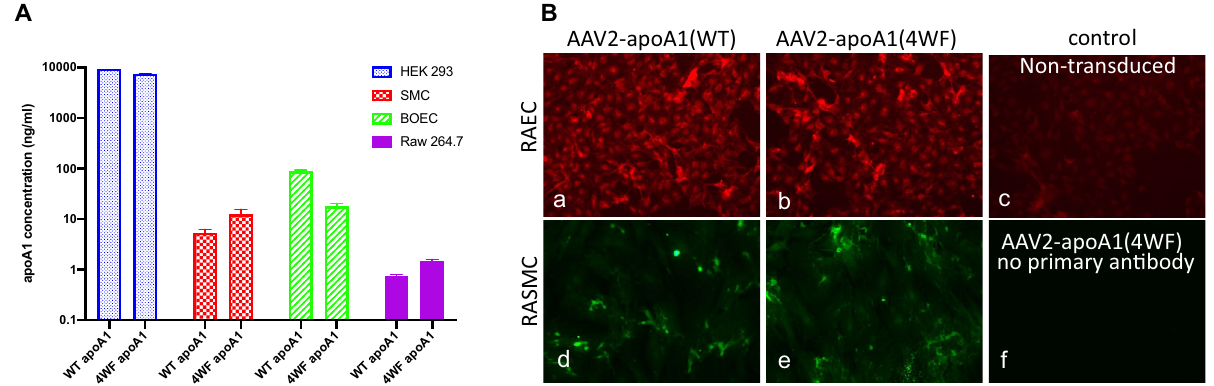
Figure 1. ApoA1 production following AAV2-apoA1(WT) and AAV2-apoA1(4WF) transduction assayed by ELISA and immunofluorescence. ( A ) Human embryonic kidney cells (HEK-293), rat smooth muscle cells (SMC), rat blood outgrowth endothelial cells (BOEC), and murine macrophages (Raw 264.7) were transduced with AAV2-apoA1(WT) and AAV2-apoA1(4WF). ApoA1 production was determined by ELISA of the media conditioned by transduced cells 3 days post-transduction. ( B ) Rat endothelial cells (a-c) and rat smooth muscle cells (d-f) were transduced with either AAV2-apoA1(WT) (a and d) or AAV2-apoA1(4WF) (b, e and f) for 3 days, methanol-fixed and reacted with anti-apoA1 antibody except (c), followed by either Cy 3.5- (a, b and c) or AlexaFluor488-labeled (d, e and f) secondary antibodies. Original magnification is